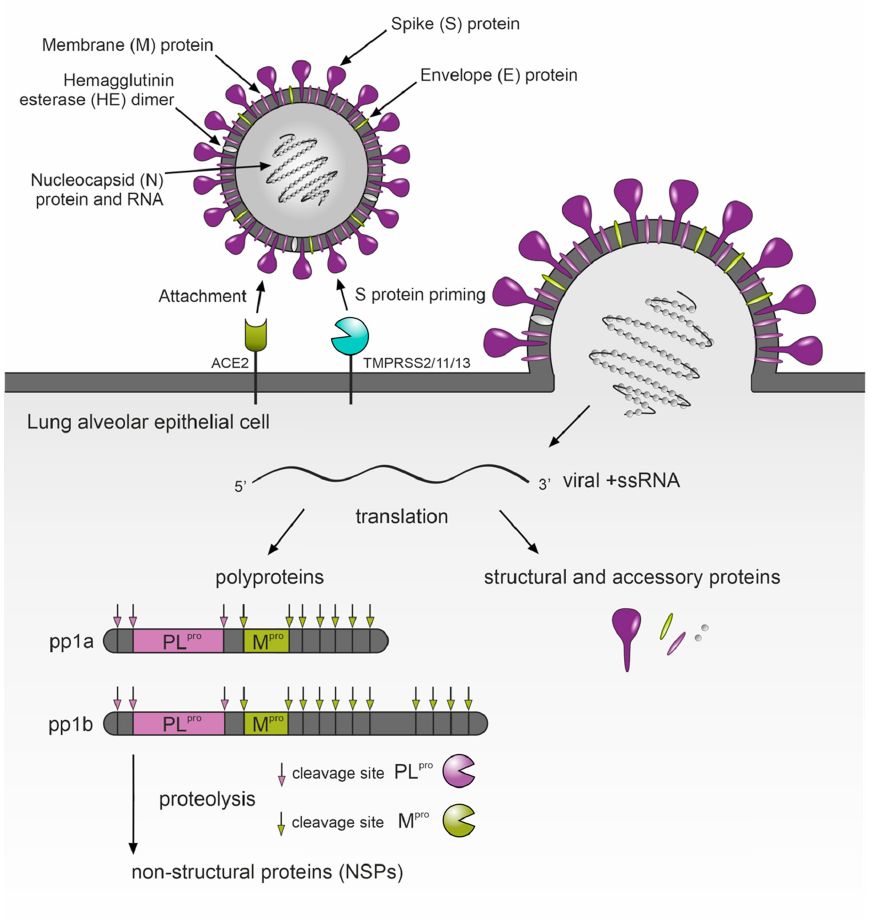
Figure 3. Schematic model of SARS-CoV-2 virus entry into lung cells. The initial attachment of the virus is mediated by SARS-CoV-2 S protein engagement with host ACE2 receptors. Upon ACE2 binding, the viral S protein is proteolytically cleaved by host surface proteases TMPRSS2/11/13 enabling the fusion of the viral envelope and the cell membrane. The nucleocapsid is released into the host cell cytoplasm and the virus initiates replication. The viral +ssRNA encodes two polyproteins, pp1a and pp1b, that are further proteolytically processed into 16 non-structural proteins (NSPs) to form a replication–transcription complex (RTC) and several structural proteins that are required for virus replication, alteration of host defense mechanisms and the formation of new virus particles. ACE2: angiotensin-converting enzyme 2; TMPRSS2/11/13: transmembrane serine protease 2, 11 and 13; +ssRNA: positive strand RNA; pp1a and pp1(a)b: two viral polyproteins encoded by ORF1a and ORF1b, respectively; PL pro : SARS-CoV-2 papain-like protease; M pro : SARS- CoV-2 major protease; pink and green arrows: PL pro and M pro cleavage sites.